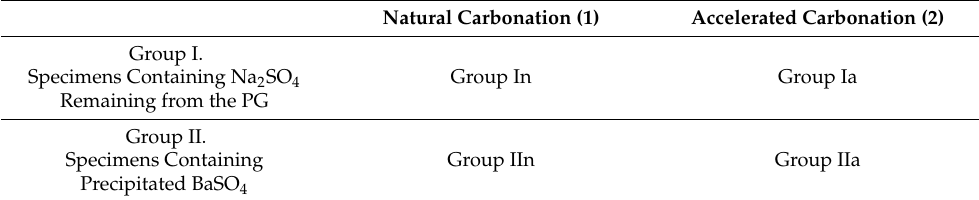
Table 3. Sample groups and